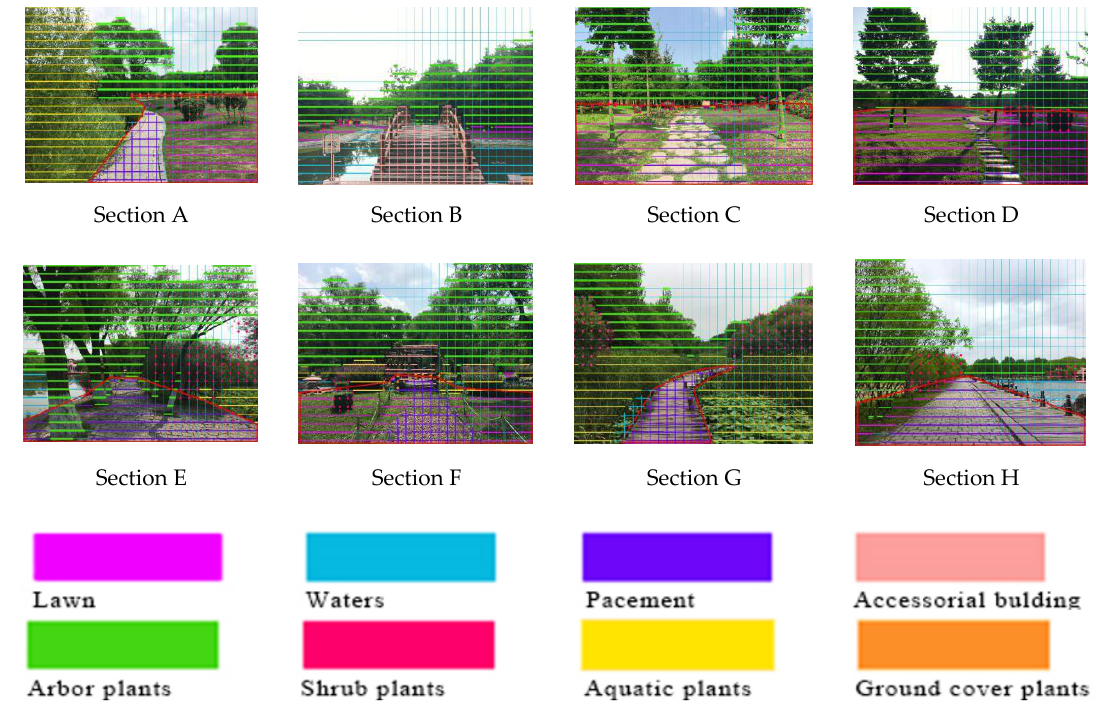
Figure 3. Schematic diagram of experimental path grid pixels.